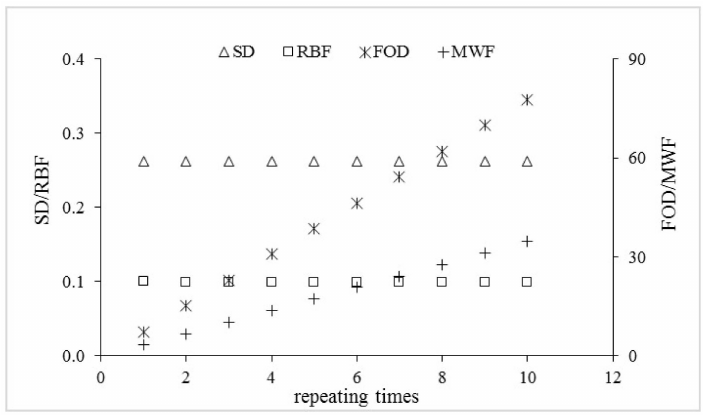
Figure 8. Comparison of indices with different numbers of